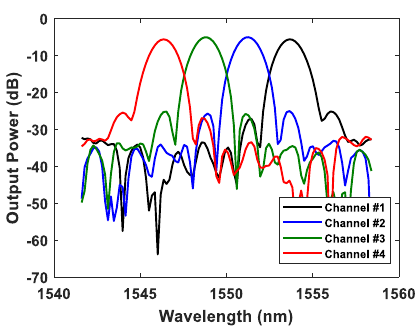
Fig. 3. Spectrum at each output of the device .